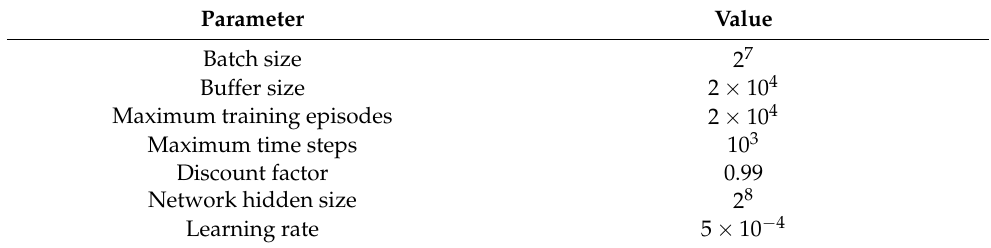
Table 1. The main parameters of the algorithm.